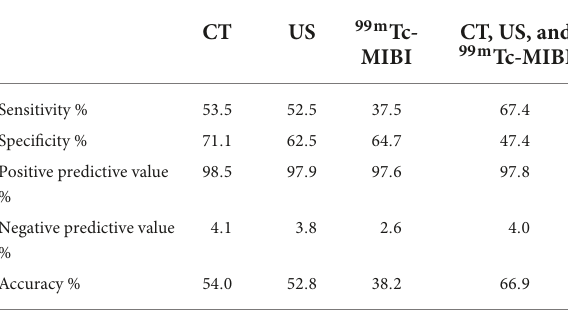
TABLE 12 Diagnostic validity of preoperative imaging studies in patients with successful